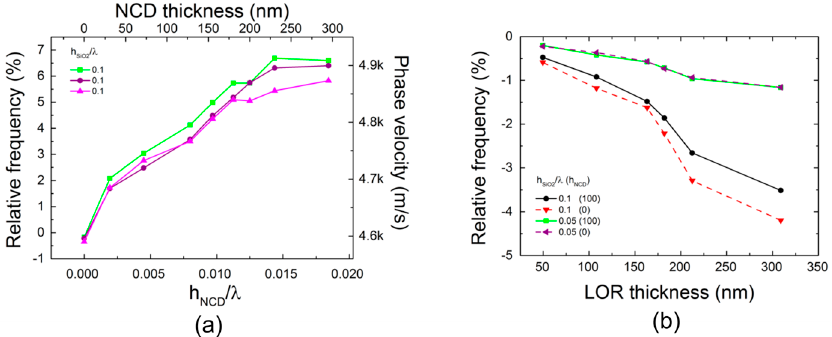
Figure 2. ( a ) Relative frequency shift and phase velocity of LW-SAW sensors with various thicknesses of NCD coating for a silica’s normalized thickness h SiO2 / λ = 0.1; ( b ) Relative center frequency shift as a function of the LOR